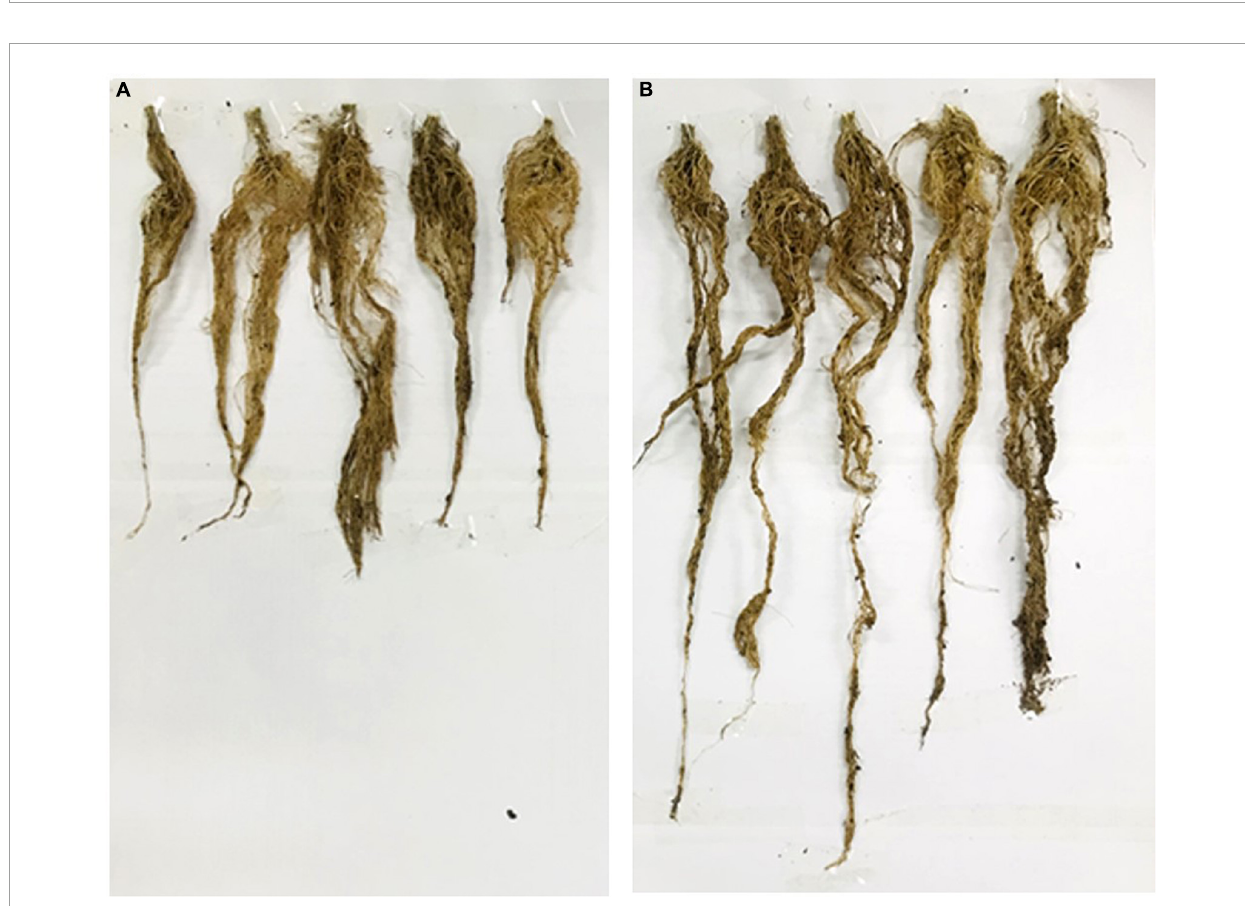
FIGURE3 Phenotypic expression of the tomato plant roots: Non-inoculated control plants (A) . Root length of RG36 T treated plants was also significantly higher than non-inoculated control plants (B)